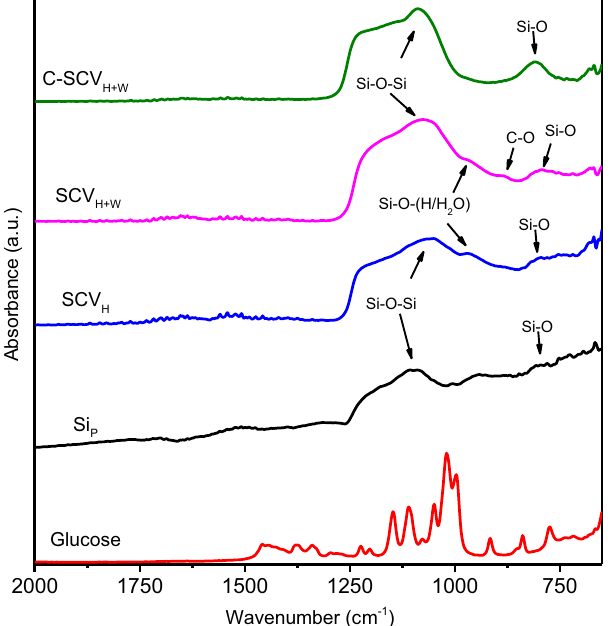
Figure 6. ATR-FTIR spectra for glucose, Si P , SCV H , SCV H + W and C-SCV H + W , respectively.